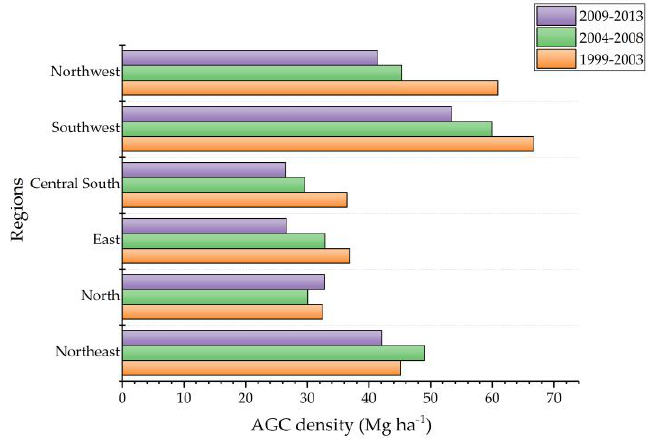
Figure 6. Aboveground carbon (AGC) density at three stages in different regions of China. The three periods correspond to the sixth, seventh, and eighth forest resources inventories.